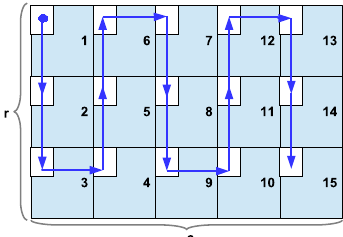
Figure 6. Reading image example among the grid neighborhood of the image.